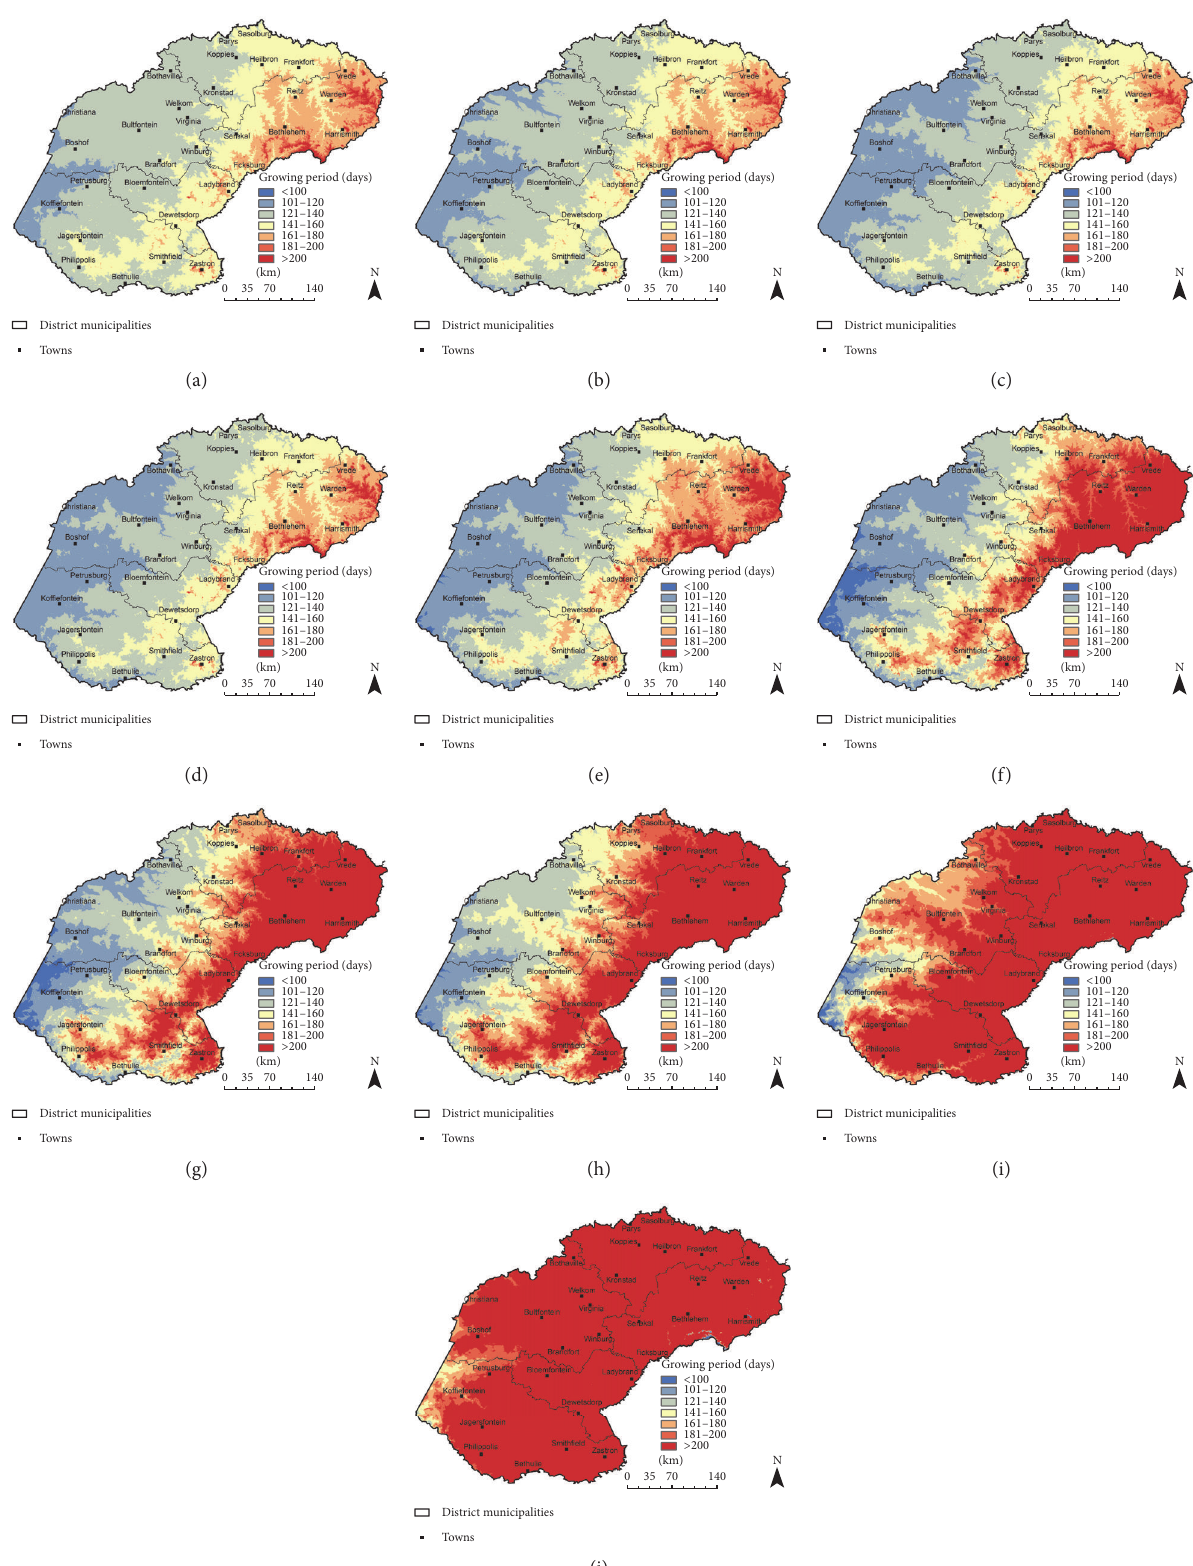
Figure 6: Growing period in days at 50% nonexceedence probability for a medium-late season maize variety planted in the (a) 1st dekad of October, (b) 2nd dekad of October, (c) 3rd dekad of October, (d) 1st dekad of November, (e) 2nd dekad of November, (f) 3rd dekad of November, (g) 1st dekad of December, (h) 2nd dekad of December, (i) 3rd dekad of December, and (j) 1st dekad of